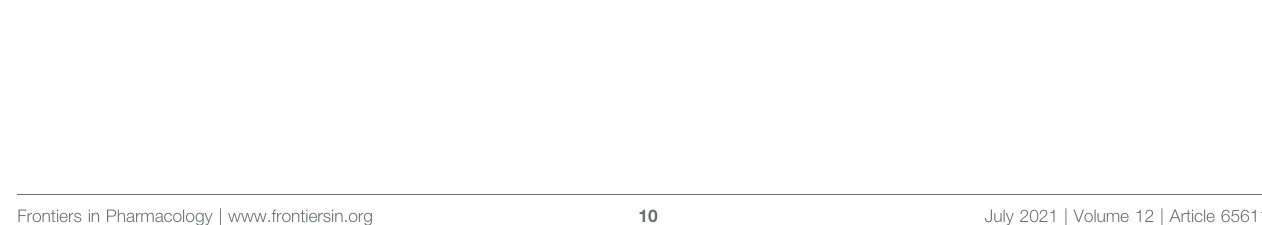
Frontiers in Pharmacology |